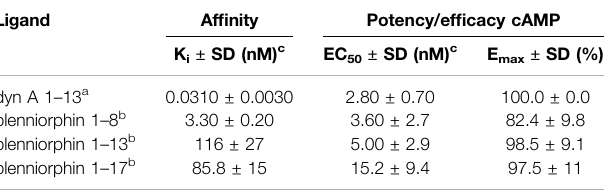
TABLE 2 | Pharmacological data of blenniorphins at the KOR. Ligand Af fi nity Potency/ef fi cacy